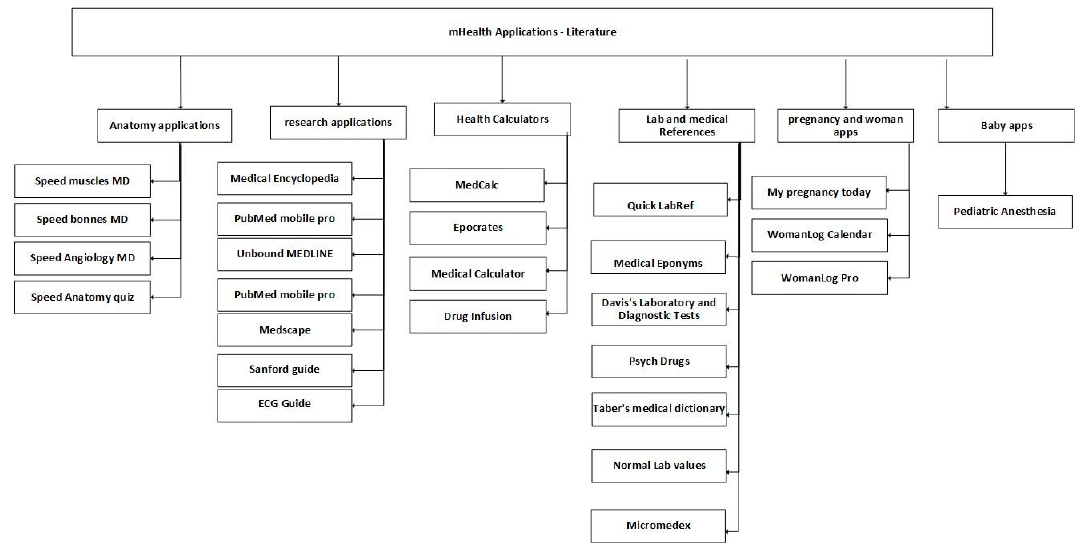
Figure 9. Classification of mobile health applications related to literature .